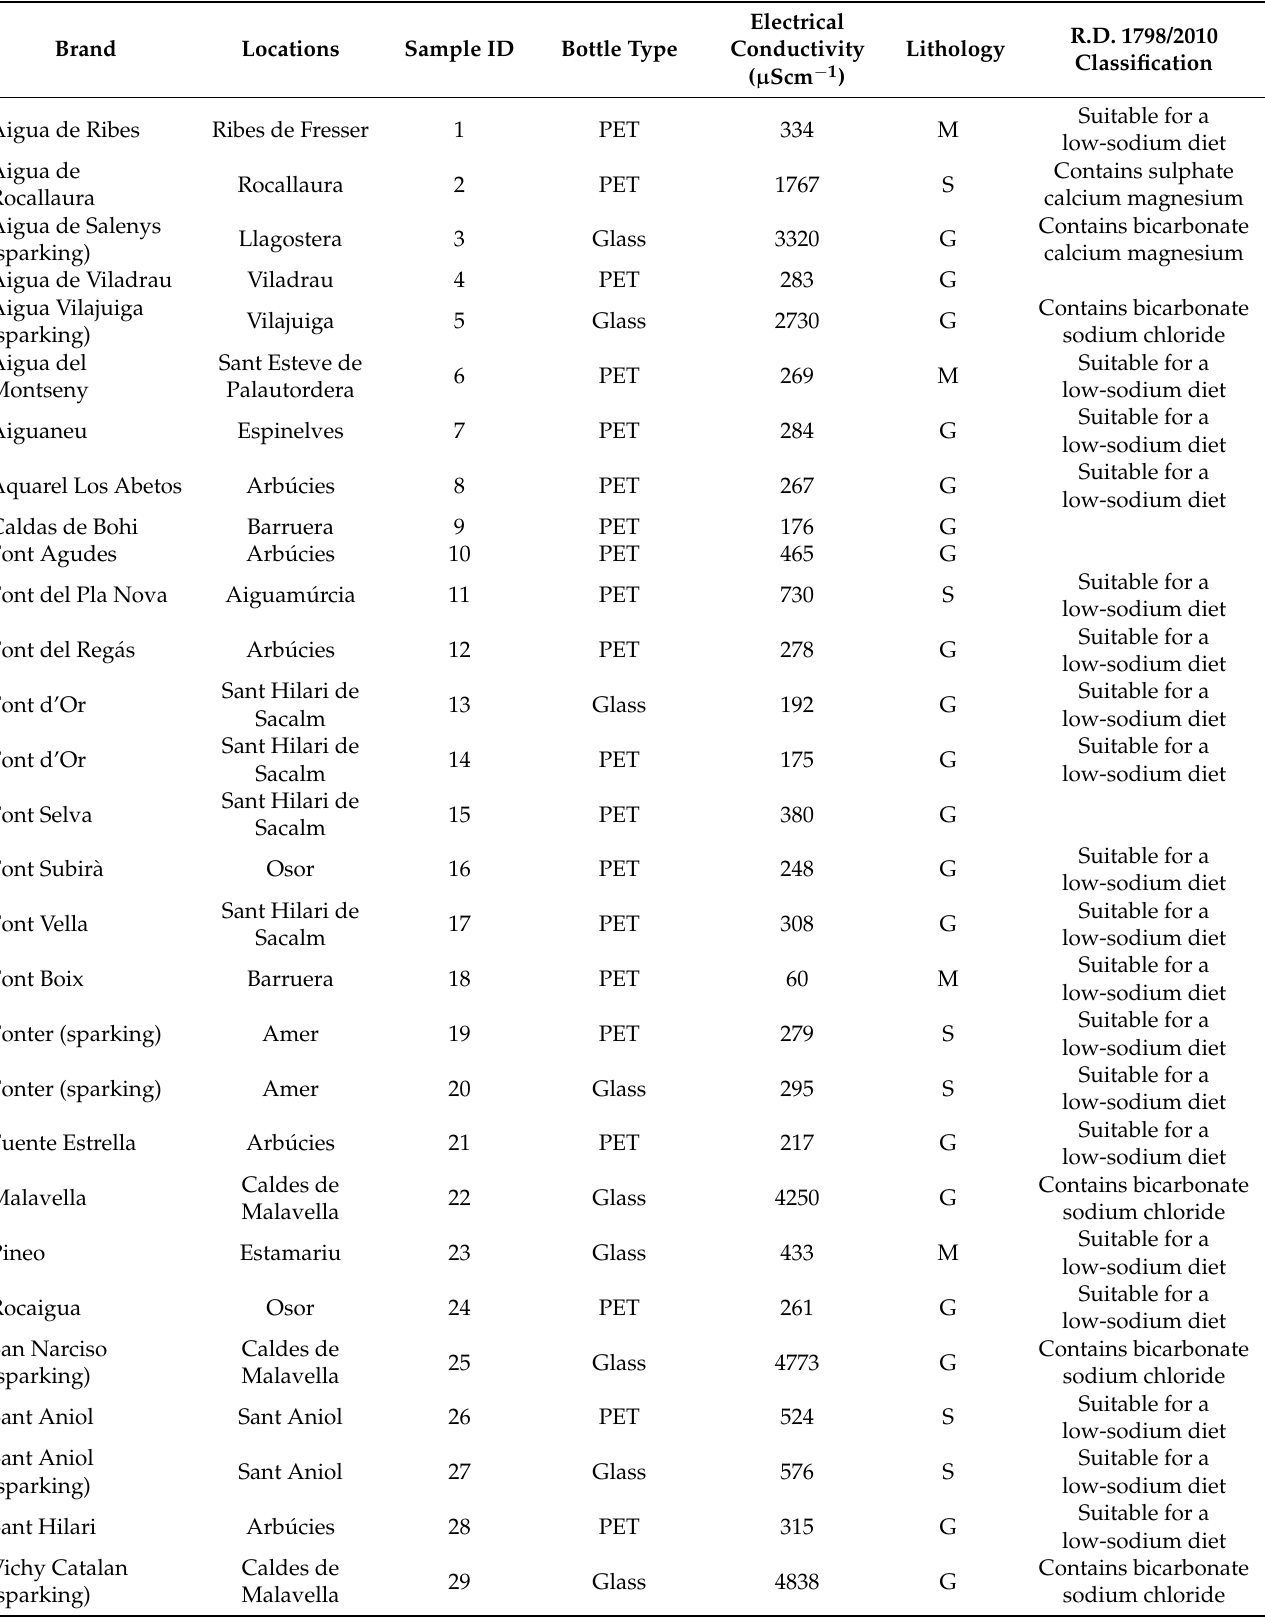
Table 1. Sample sources, bottle type, classification and details of analysed mineral waters. Lithology: G: Granites; S: Sedimentary rocks; M: Metamorphic